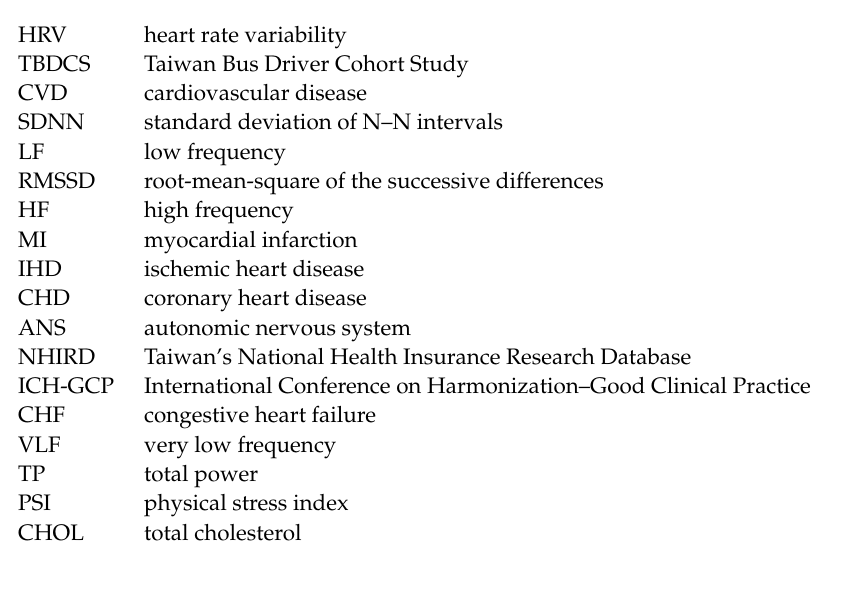
Table S1: Definition of HRV measures, Table S2: Compared HRV index for cardiovascular diagnostic categories in study population ( n = 788), Table S3: Hazard ratios and 95% confidence intervals for cardiovascular diagnostic categories by HRV index in the study population ( n =